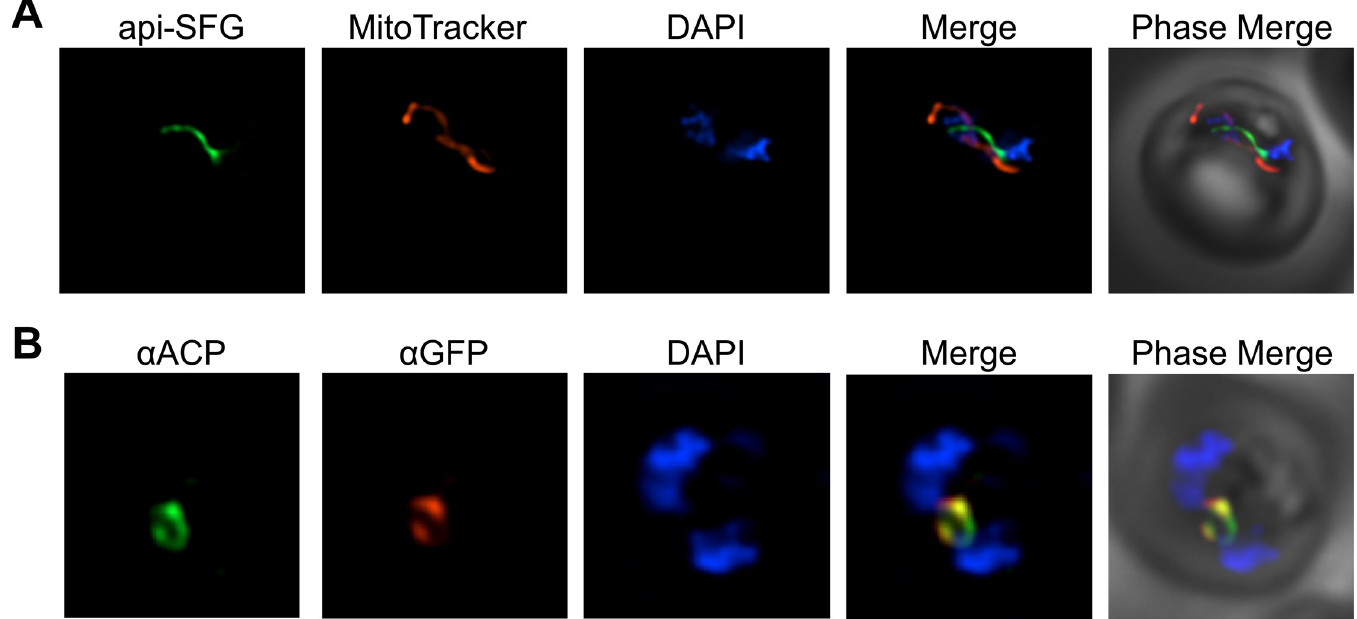
Fig 3. Fluorescent labeling of the apicoplast organelle in PfMev parasites and confirmation via co-localization. A) Live fluorescence microscopy of the PfMev line expressing the signal sequence and transit peptide from ACP fused to SFG (green), the mitochondria was stained with MitoTracker (red), and nuclear DNA was stained with DAPI (blue). B) Immunofluorescence co-localization of aSFG with the apicoplast marker ACP, with α -ACP (green), α -GFP (red), with nuclear DNA stained with DAPI (blue) in fixed PfMev parasites. Images depict fields that are 10 microns long by 10 microns wide.